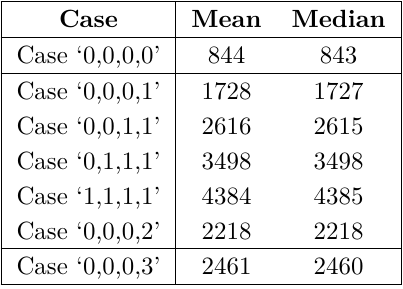
Table 3: Statistics on the number of zeros in the Walsh transform. We recall that “Case” is the list of the four kernel dimensions, sorted in increasing